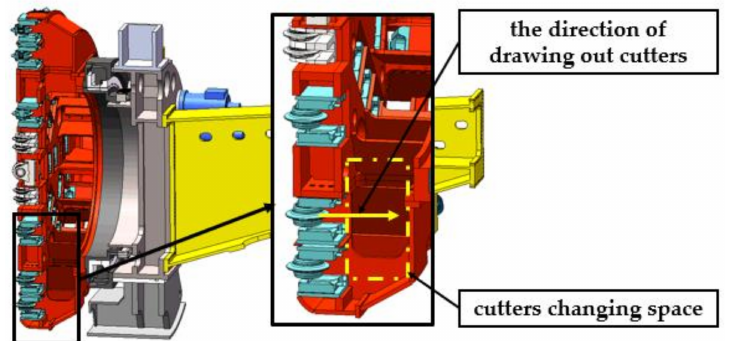
Figure 5. Schematic diagram of the TBM cutter change space and drawing